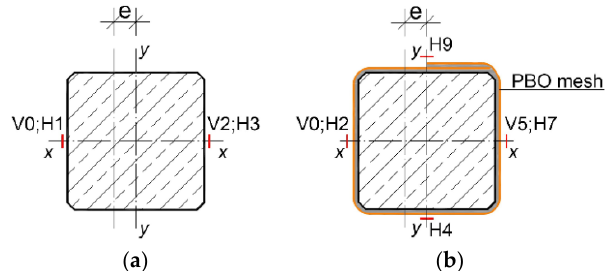
Figure 5. Instrumentation for columns. ( a ) reference columns; ( b ) reinforced columns